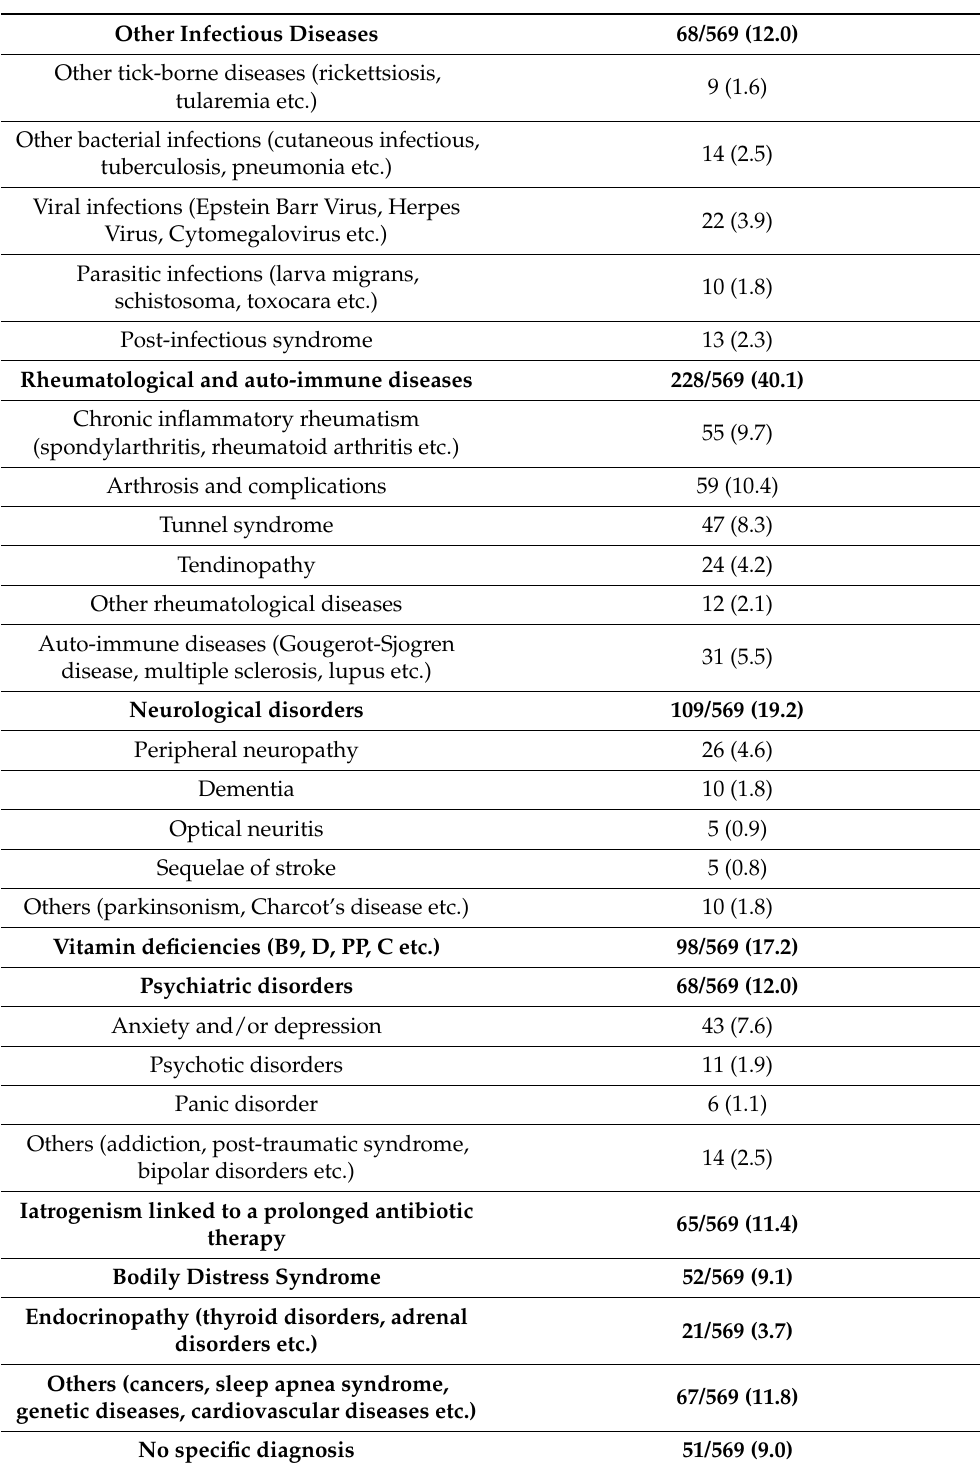
Table 2. Detailed description of the differential or associated diagnoses made at the TBD-RC of Paris and Northern region. Other Infectious Diseases 68/569 (12.0) Other tick-borne diseases (rickettsiosis, tularemia etc.) Other bacterial infections (cutaneous infectious, tuberculosis, pneumonia